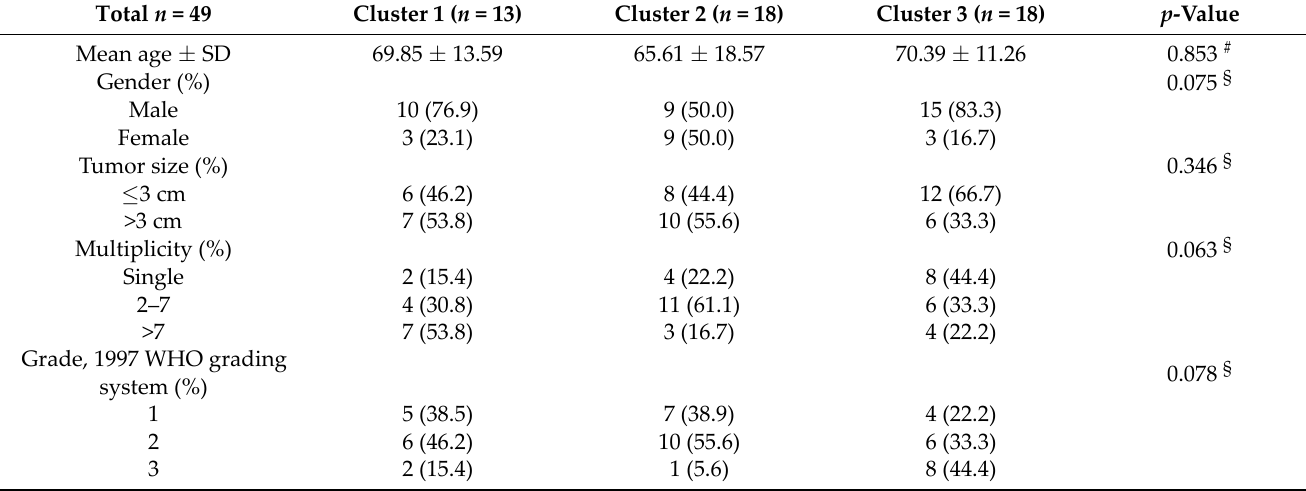
Table 7. Clinicopathological characteristics of primary non‑muscle‑invasive bladder cancer patients used to develop the subtype